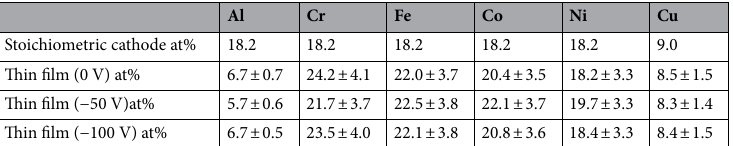
Table 2. Atomic percentage of the HEA elements in the cathode and thin films deposited with various substrate bias.